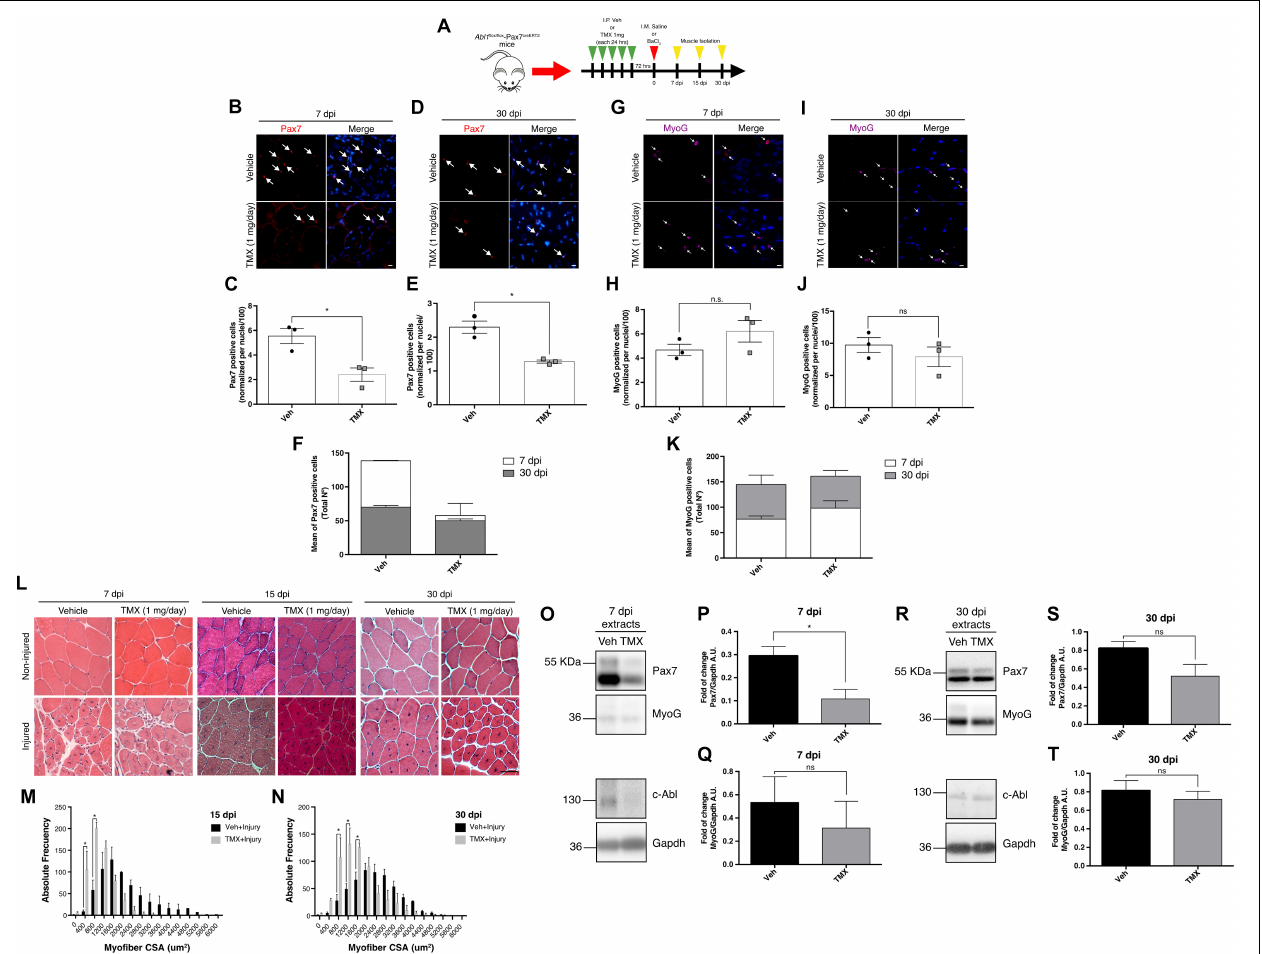
FIGURE 8 | Specific deletion of c-Abl in SCs impairs muscle regeneration. (A) Protocol for muscle regeneration in Abl1 flox / flox -Pax7 creERT2 . Mice were injected intraperitoneally (I.P.) with vehicle (Veh) or Tamoxifen (TMX, 1 mg daily) for five consecutive days. Then, after 72 h, muscle injury was induced by intramuscular (I.M.) injection of BaCl 2 in the tibialis anterior (TA) muscle. Contralateral muscles were injected with saline solution as control. Next, muscles were isolated at 7-, 15-, and 30-days post-injury (dpi). (B,D) Pax7 positive cells decrease in SC-Abl KO mice during muscle regeneration. IF against Pax7 (red) was performed in 7 dpi (B) and 30 dpi (D) muscle sections. Nuclei were stained with Hoechst 33342 (blue). Arrows show Pax7 positive cells. Scale bar: 10 µ m. Plots (C,E) show quantification for Pax7 positive cells normalized per 100 nuclei for 7 and 30 dpi respectively ( n = 3, * P -value < 0.05, Mann–Whitney test). (F) Graph shows the mean of total Pax7 positive cells by mouse. (G,I) Myogenin (MyoG) positive cells in SC-Abl KO mice during muscle regeneration. IF against MyoG (magenta) was performed in 7 dpi (G) and 30 dpi (I) muscle sections. Nuclei were stained with Hoechst 33342 (blue). Arrows show MyoG positive cells. Scale bar: 10 µ m. Plots (H,J) show quantification for MyoG positive cells normalized per 100 nuclei for 7 and 30 dpi respectively ( n = 3, P -value > 0.05, Mann–Whitney test, ns: not significant). (K) Graph shows the mean of total MyoG positive cells by mouse. (L) Decrease in cross-sectional area (CSA) of regenerative myofibers from c-Abl KO mice. Sections from TA muscles were stained with Hematoxylin-Eosin stain. Upper panels: non-injured contralateral muscles; Lower panels: injured TA. Scale bar: 50 µ m. (M) Distribution of CSA of regenerative myofibers at 15 dpi. (N) Distribution of CSA of regenerative myofibers at 30 dpi ( n = 3, * P -value < 0.05, Two-way ANOVA test). (O,R) Pax7 protein levels decrease during muscle regeneration in c-Abl KO mice. 7 and 30 dpi TA were lysed, and WB using anti-Pax7, anti-Myogenin (MyoG), or anti-c-Abl was performed. Gapdh was used to normalize protein levels. (P,Q) Quantification of normalized Pax7 and MyoG protein levels from 7 dpi extracts (O) . A.U., arbitrary units ( n = 3, * P -value < 0.05, Mann–Whitney test, ns: not significant). (S,T) Quantification of normalized Pax7 and MyoG protein levels from 30 dpi extracts (R) . A.U., arbitrary units ( n = 3, P -value > 0.05, Mann–Whitney test, ns, not